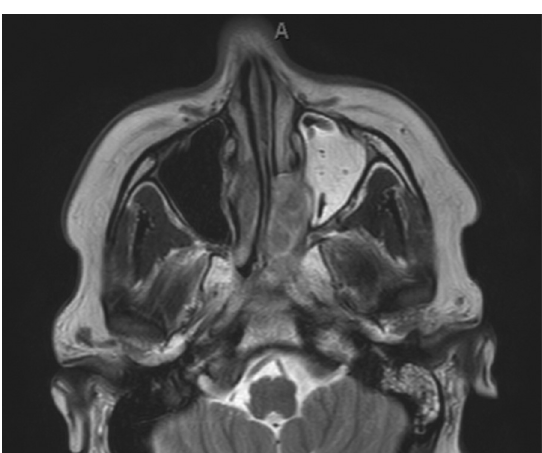
MRI, axial view, T1, post-contrast showing marked enhanced lesion.